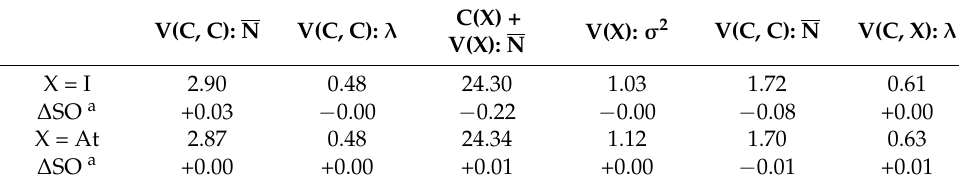
Figure 1. ELF localization domains for the C 6 At 6 species (ELF isosurface = 0.75) at the 2c-PW6B95- D3/TZVPPD level of theory. Color code: magenta for core basins, red for valence non-bonding basins, and green for bonding basins. Table 1. ELF electron population analysis of C 6 X 6 species (X = I, At) obtained at the 2c-PW6B95- D3/TZVPPD level of